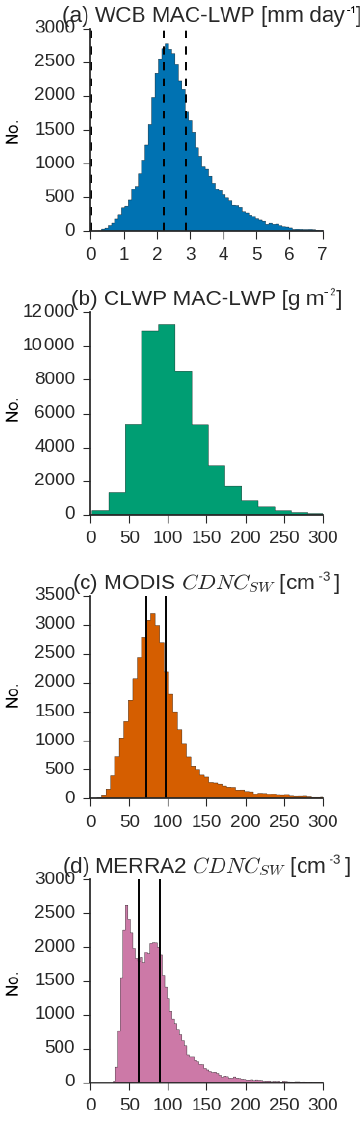
Figure 5. Distributions of cyclone-mean properties within the 2003–2015 observational record. Units are noted for each variable. The number of composite cyclones with that value is indicated on the ordinate. Warm conveyor belt (WCB) moisture flux is shown in panel (a) . Cyclone LWP (precipitating and non-precipitating liq- uid) is shown in (b) . Observations and MERRA2-inferred values of CDNC in the southwest quadrant of the cyclone (CDNC SW ) are shown in panels (c–d) . In panels (c) and (d) the top and bottom third of distribution are indicated with dashed lines. In panel (a) edges of the WCB terciles used in Fig. 3 are shown with dashed